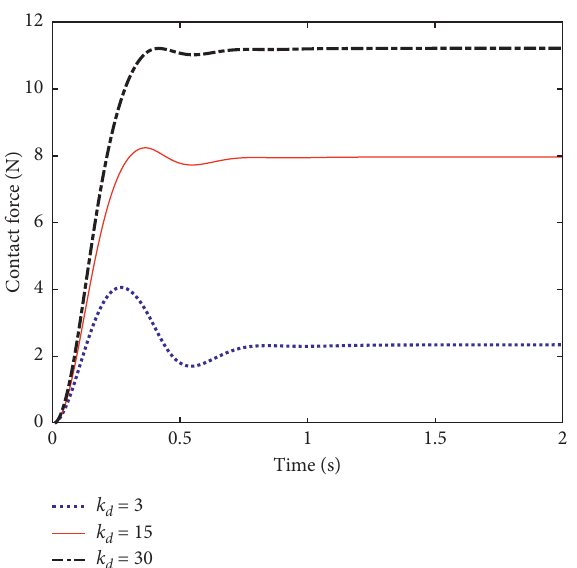
Figure 13: Contact force curves with different stiffness